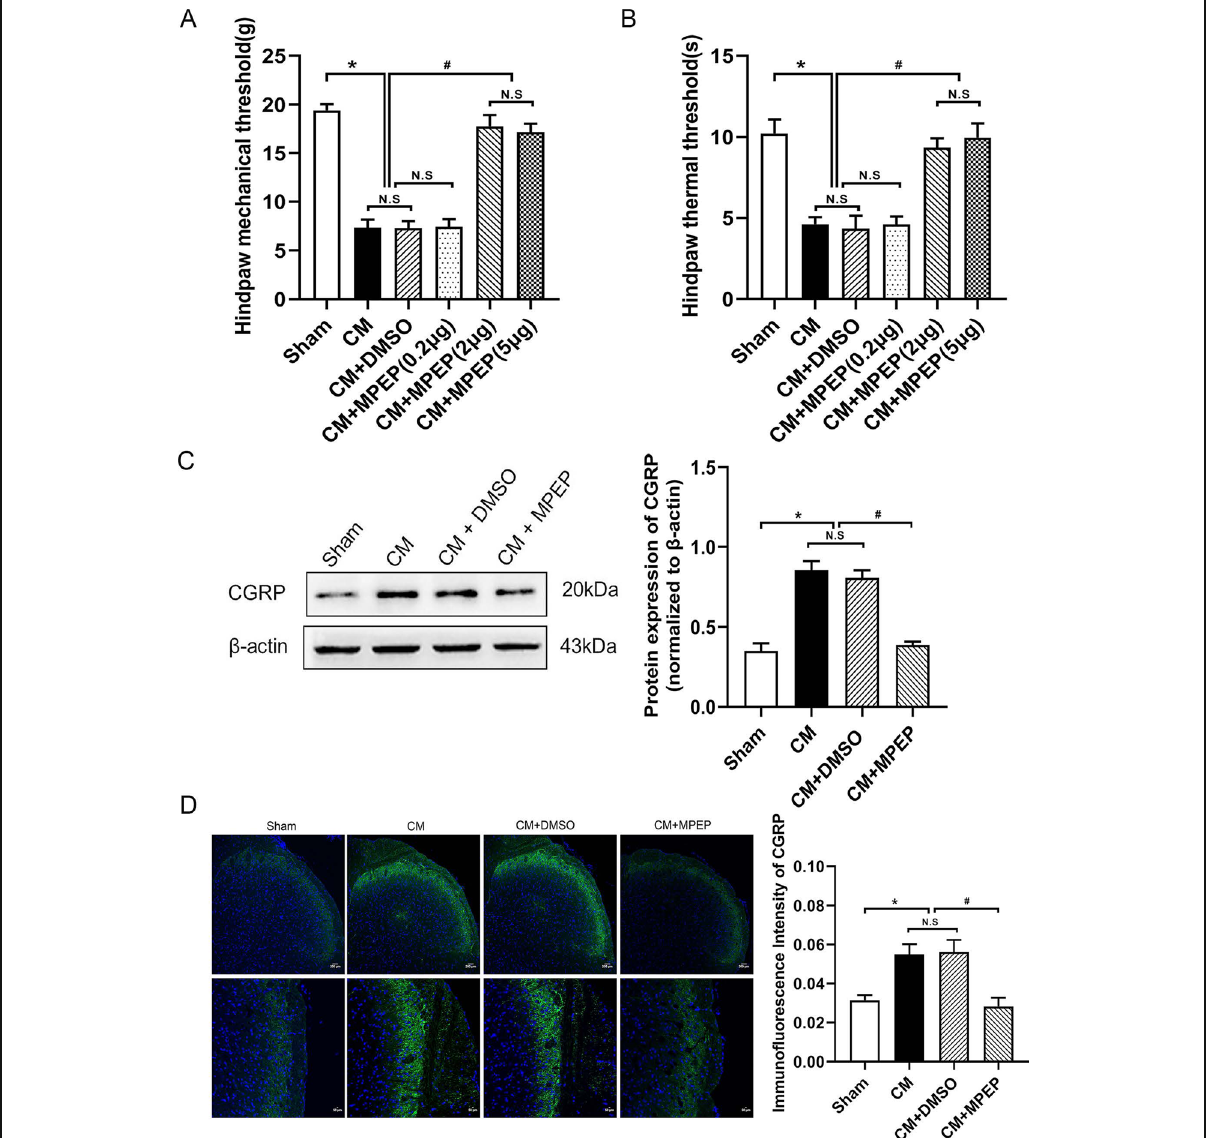
Fig. 3 The effect of MPEP on mechanical allodynia, thermal allodynia, and the expression of CGRP. a-b Compared with the sham group, pain thresholds significantly decreased in the CM group. There were no significant differences between the CM and CM+DMSO groups. Compared with the CM and CM+DMSO groups, 0.2 μ g MPEP did not effect, while 2 μ g and 5 μ g MPEP all increased the pain thresholds. There were no significant differences between the CM+MPEP(2 μ g) and CM+MPEP(5 μ g) groups. a The mechanical pain thresholds of the hind paw in different groups. b The thermal pain thresholds of the hind paw in different groups. c-d Compared with the sham group, the expression of CGRP increased in the CM group. There were no significant differences between the CM and CM+DMSO groups. The administration of MPEP significantly downregulated the expression of CGRP. c The protein expression of CGRP. d Immunoreactivity for CGRP. ( n =4 in each group, scale bar=200 μ m or scale bar=50 μ m; * p <0.05 compared with the sham group; # p <0.05 compared with the CM+DMSO group; N. S: p >0.05 between two